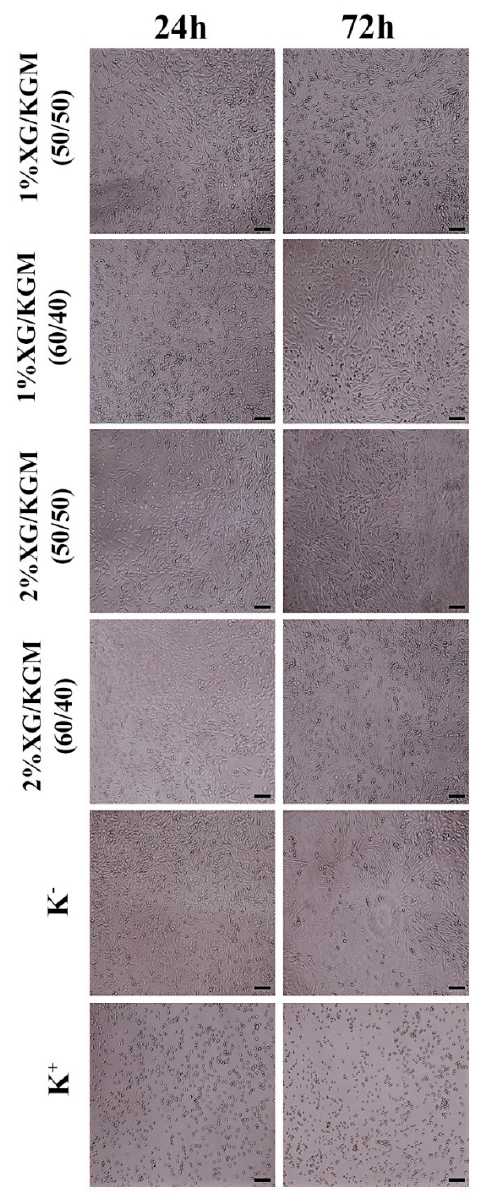
Figure 5. Microscopic images of human fibroblast cells in contact with XG / KMG hydrogels after 24 h and 72 h. K − (negative control), K + (positive control). Scale bar: 100 µm.